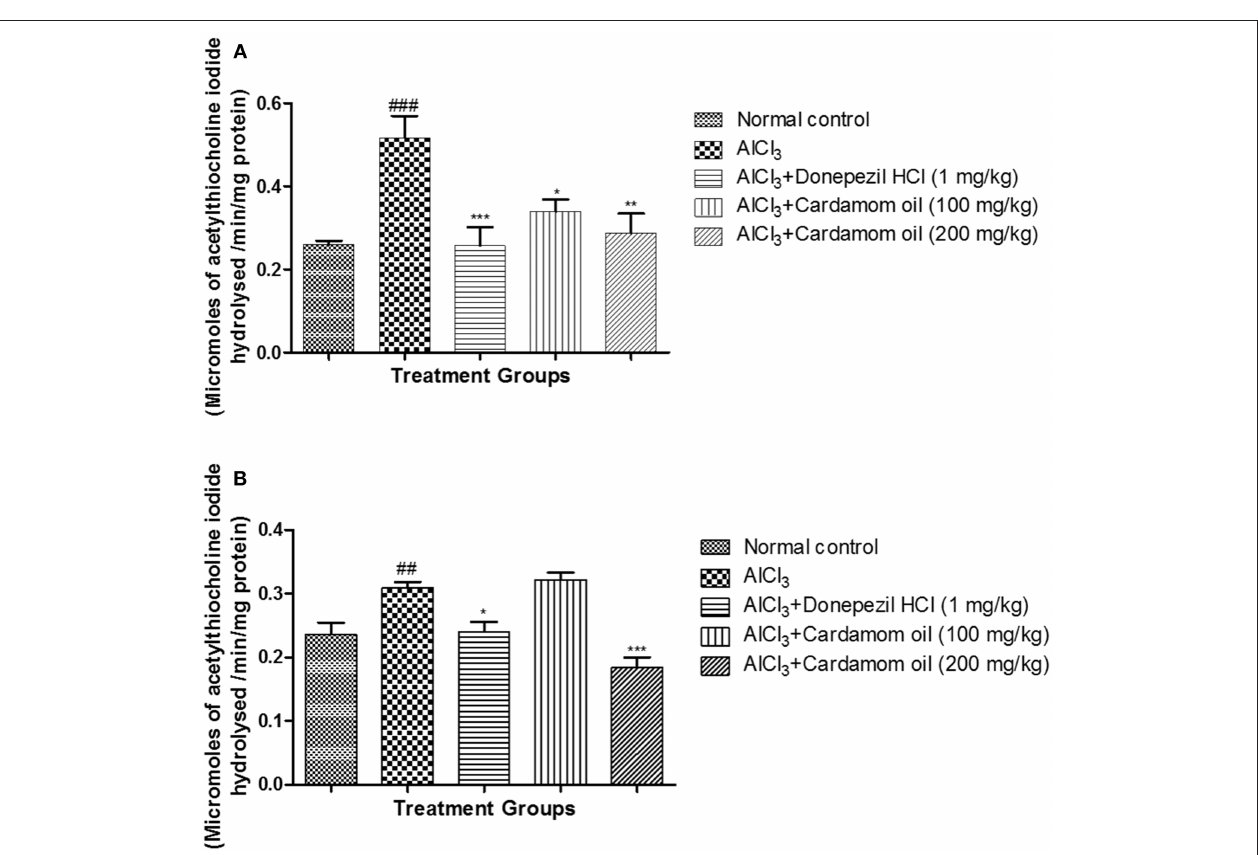
FIGURE 5 | Effect of Cardamom oil on acetylcholinesterase assay in (A) hippocampus and (B) cortex tissue in AlCl 3 -induced neurotoxicity in rats. Data are expressed as mean ± SEM ( n = 6), ##p < 0.01, ### p < 0.001 when compared with normal control, *** p < 0.001, ** p < 0.01, * p < 0.05 when compared with disease control group. AlCl 3 , Aluminum chloride; SEM, Standard Error of